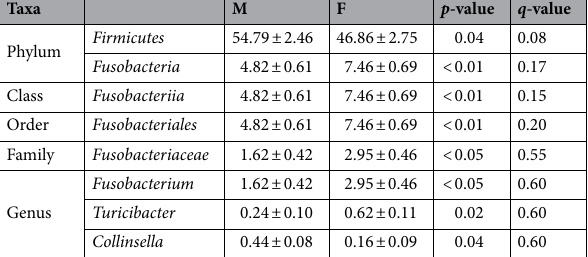
Table 4. Significantly different faecal microbiome populations of male (M, n = 16) and female (F, n = 13) dogs. Data (% of sequences) are given as LSmeans ±